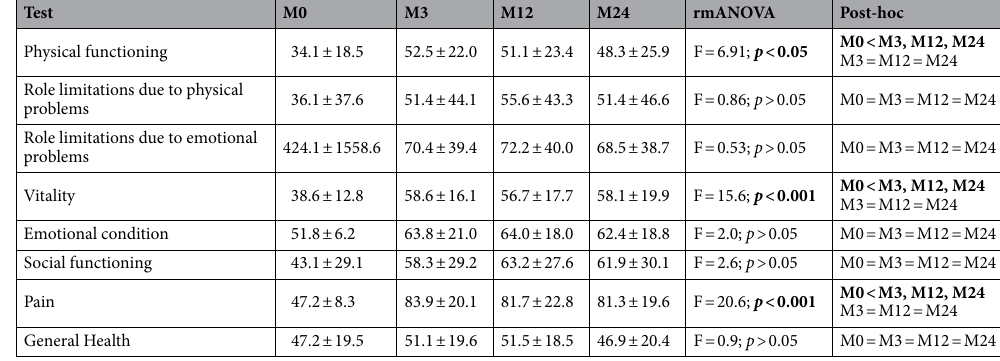
Table 2. The scores of SF-36 domains before AHSCT and 2 years after AHSCT in patients with MS. rmANOVA—Repeated measures analysis of variance, AHSCT—autologous hematopoietic stem cell transplantation, M0—before AHSCT, M3—month 3 after AHSCT, M12—month 12 after AHSCT, M24— month 24 after AHSCT. Significant values are in [bold].